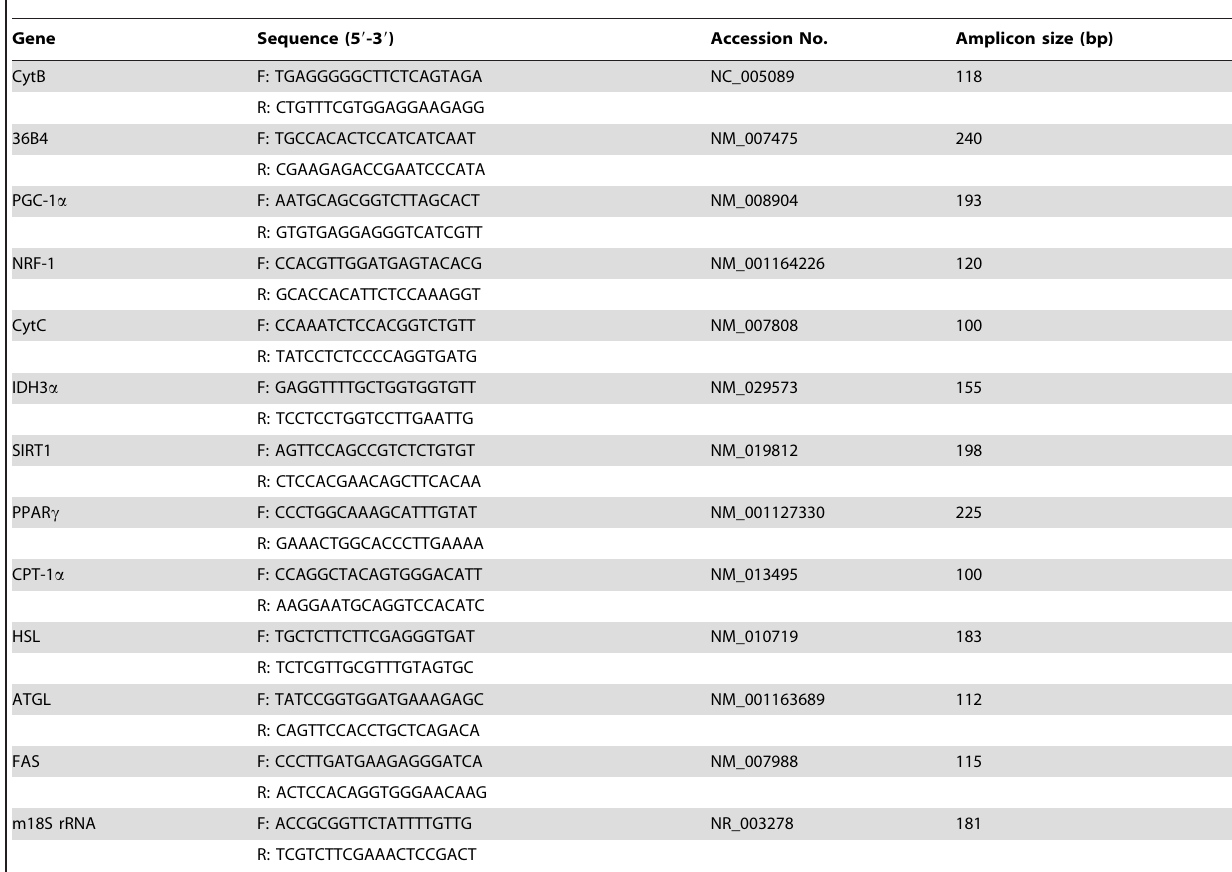
Table 1. Primer sequences used in this study.